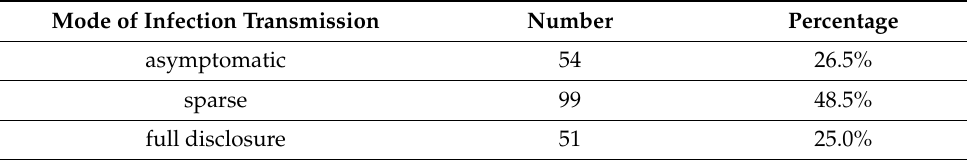
Table 3. Mode of infection transmission.